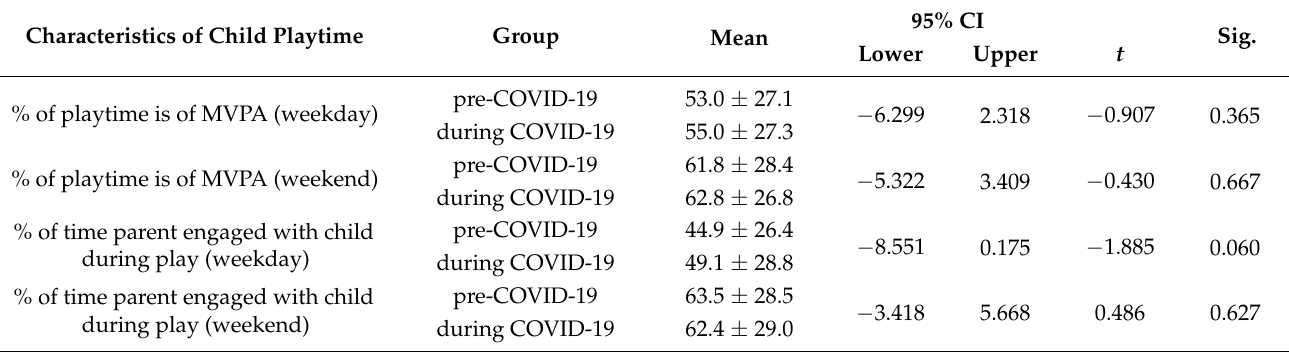
Table 4. Proportion of child playtime that is of moderate-to-vigorous intensity and the proportion of playtime parent was engaged with children before and during the COVID-19